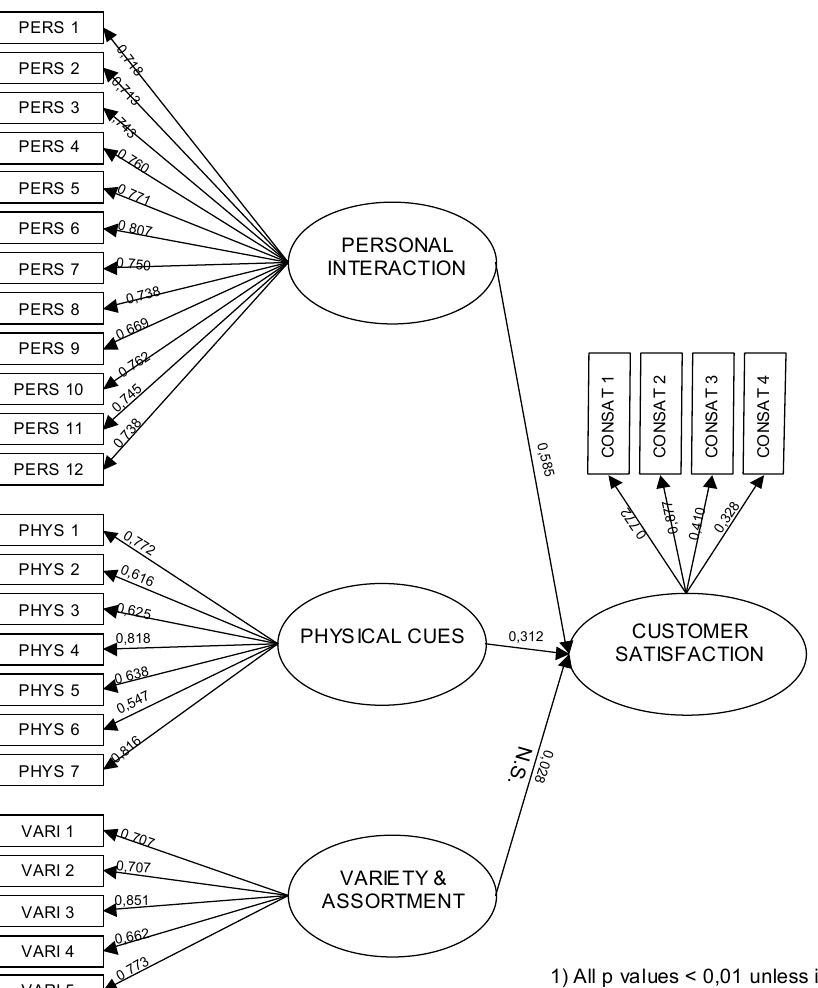
Figure 2: Empirical results: Determinants of satisfaction with selected controllable elements of the total retail